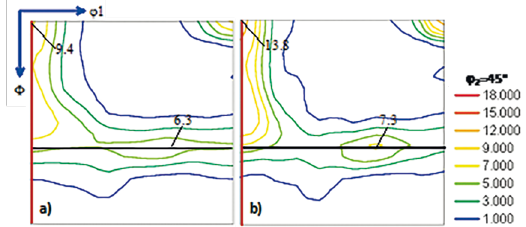
Figure 2. Macro-texture after 80% cold rolling: a) near the surface; b) center.